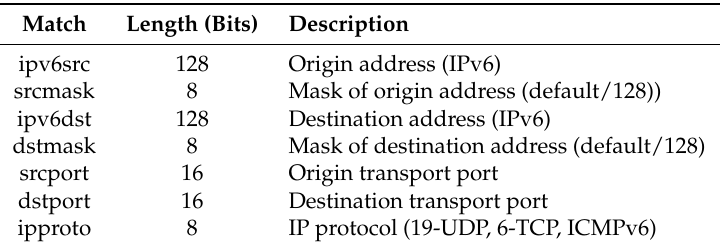
Table 1. Match field of SD6WSN flow table